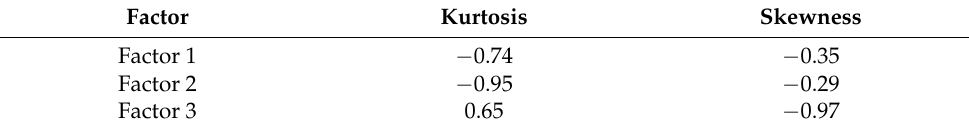
Table 5. Skewness and kurtosis of the nurses’ pandemic-related experiences questionnaire.